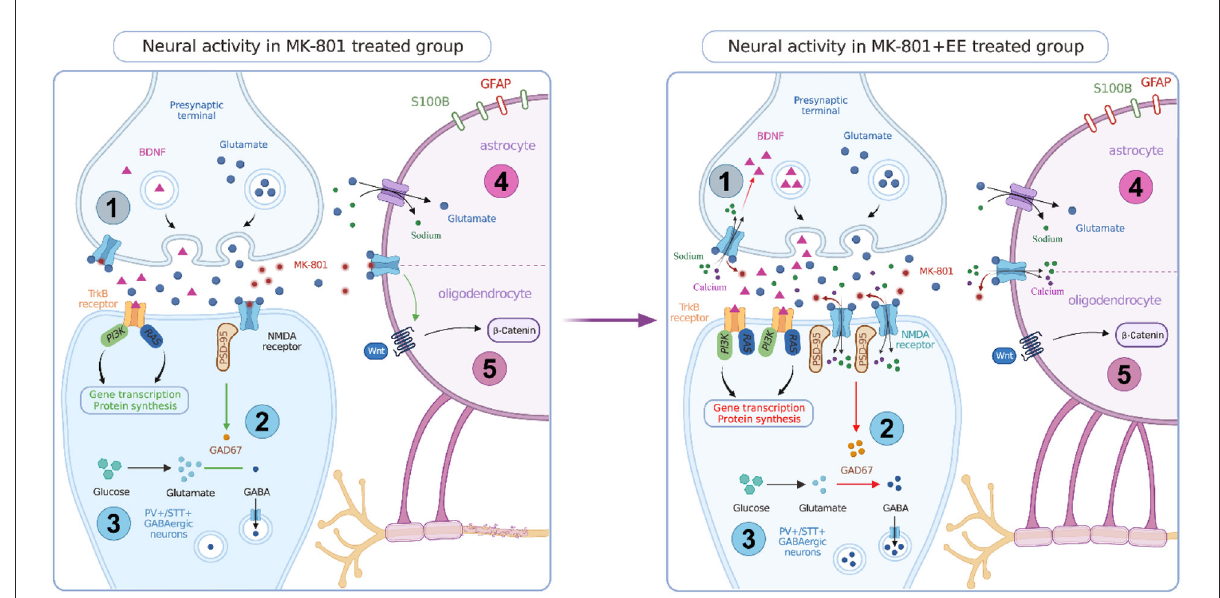
FIGURE1 Neural activity in MK-801 and MK-801 + EE treated group. ‹ EE can promote the expression of BDNF and improve the signaling function of BDNF-TrkB. › EE can rescue the blocking effect of MK-801 on NMDAR in interneurons, promote the expression of NMDAR subunits, PSD-95, and GAD 67, and promote GABA neurotransmitter synthesis. fi EE has a neurorepair effect, which can increase the number of PV + and SST + GABAergic neurons and increase the output of inhibitory signals. fl EE can rescues the regulation of glutamate by astrocytes, increase the number of GFAP positive cells and decrease the number of S100B positive cells. (cid:176) EE can activate Wnt/ β signaling pathway in oligodendrocytes and promote myelin